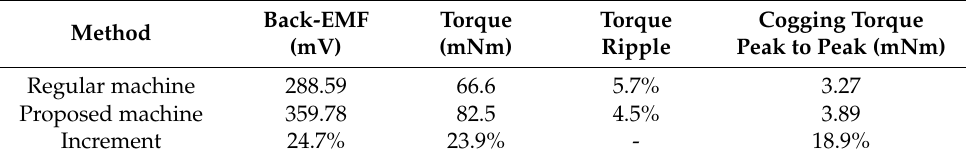
Figure 15. Comparison of performance at 50 rpm by FEM: ( a ) back-EMF; ( b ) electromagnetic torque with rated 0.4A rms current.